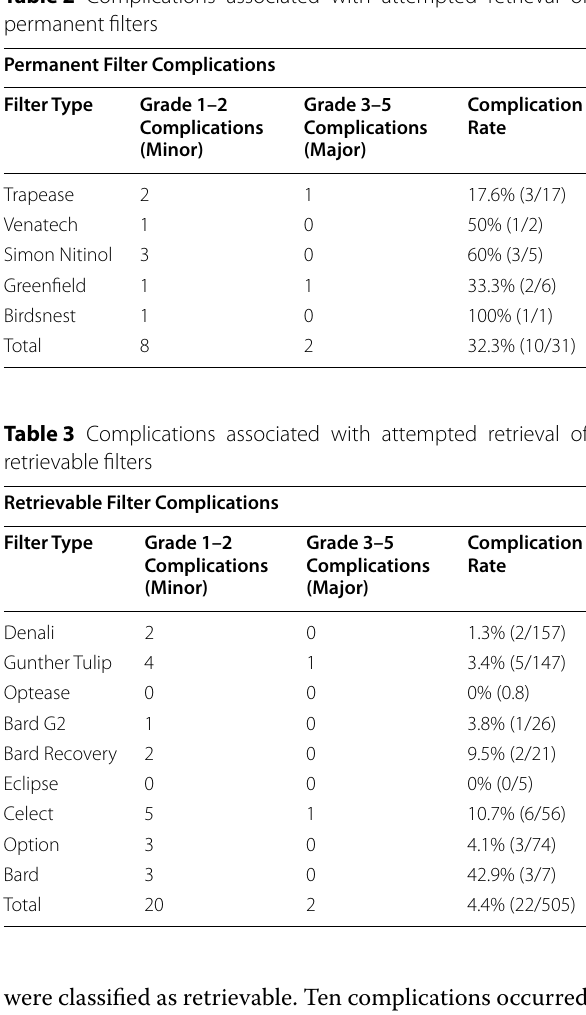
Table 2 Complications associated with attempted retrieval